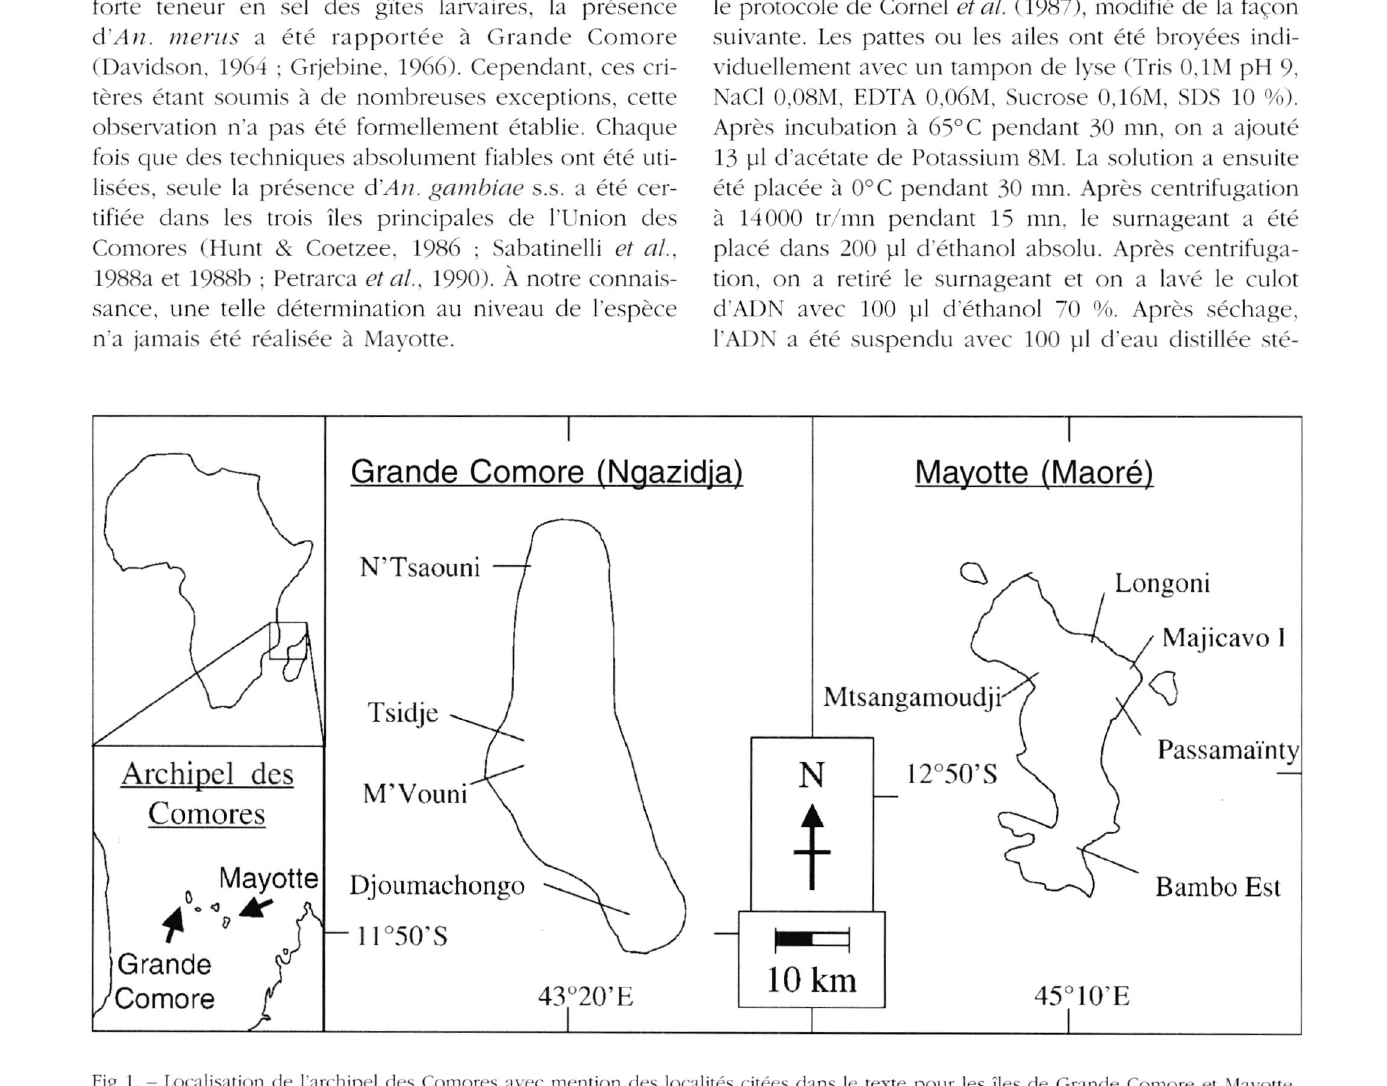
Fig 1. - Localisation de l'archipel des Comores avec mention des localités citées dans le texte pour les îles de Grande Comore et Mayotte.